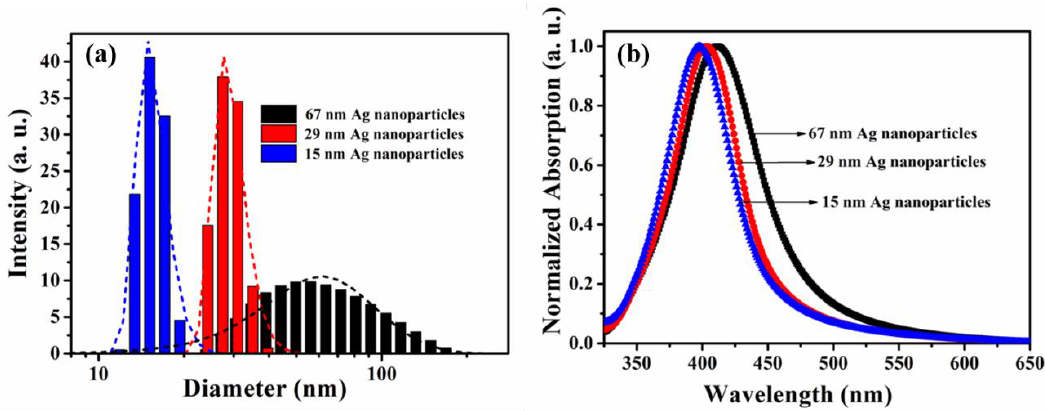
Figure 3. Normalized UV-vis absorption spectra ( a ) and size distribution ( b ) of Ag nanoparticles prepared at 0 °C, 35 °C, and 70 °C,